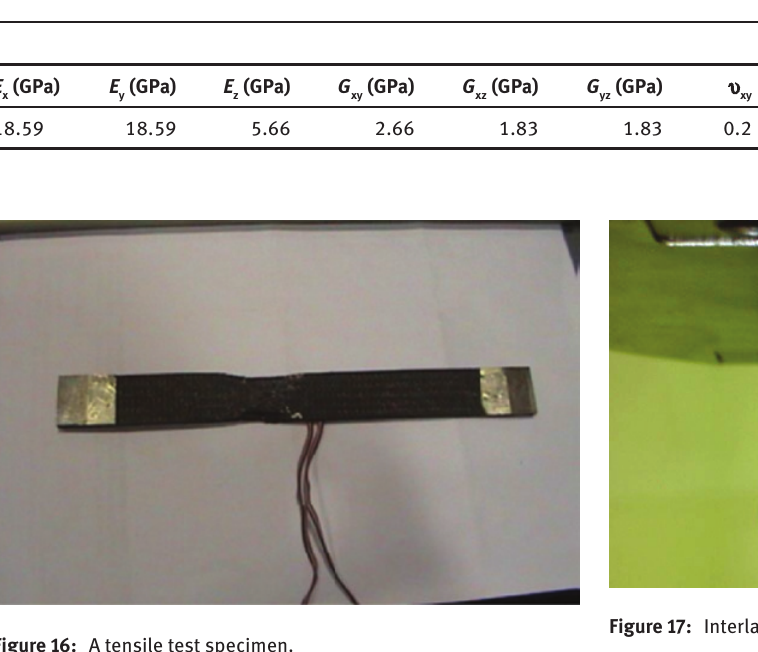
Table 5: Numerically obtained material constants (Kevlar fiber-reinforced composite).